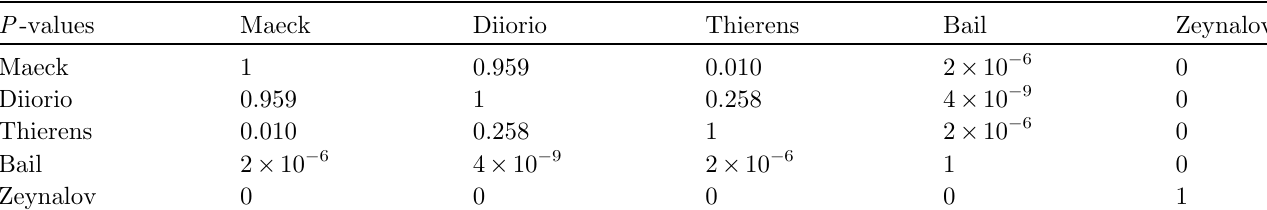
Table 2. P -values for fi ve sets of data after renormalization of data sets using the generalized x 2 method. P